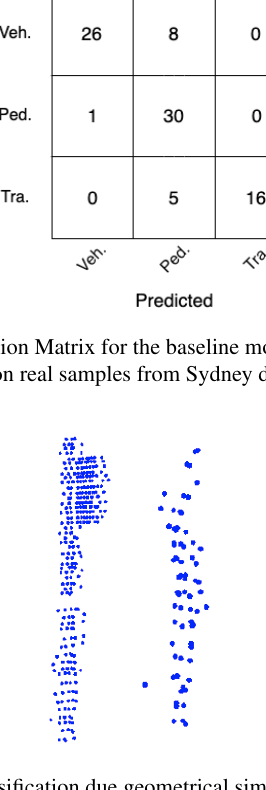
Figure 3. Misclassification due geometrical similarities between Traffic Signs (Left) and Pedestrians (Right)